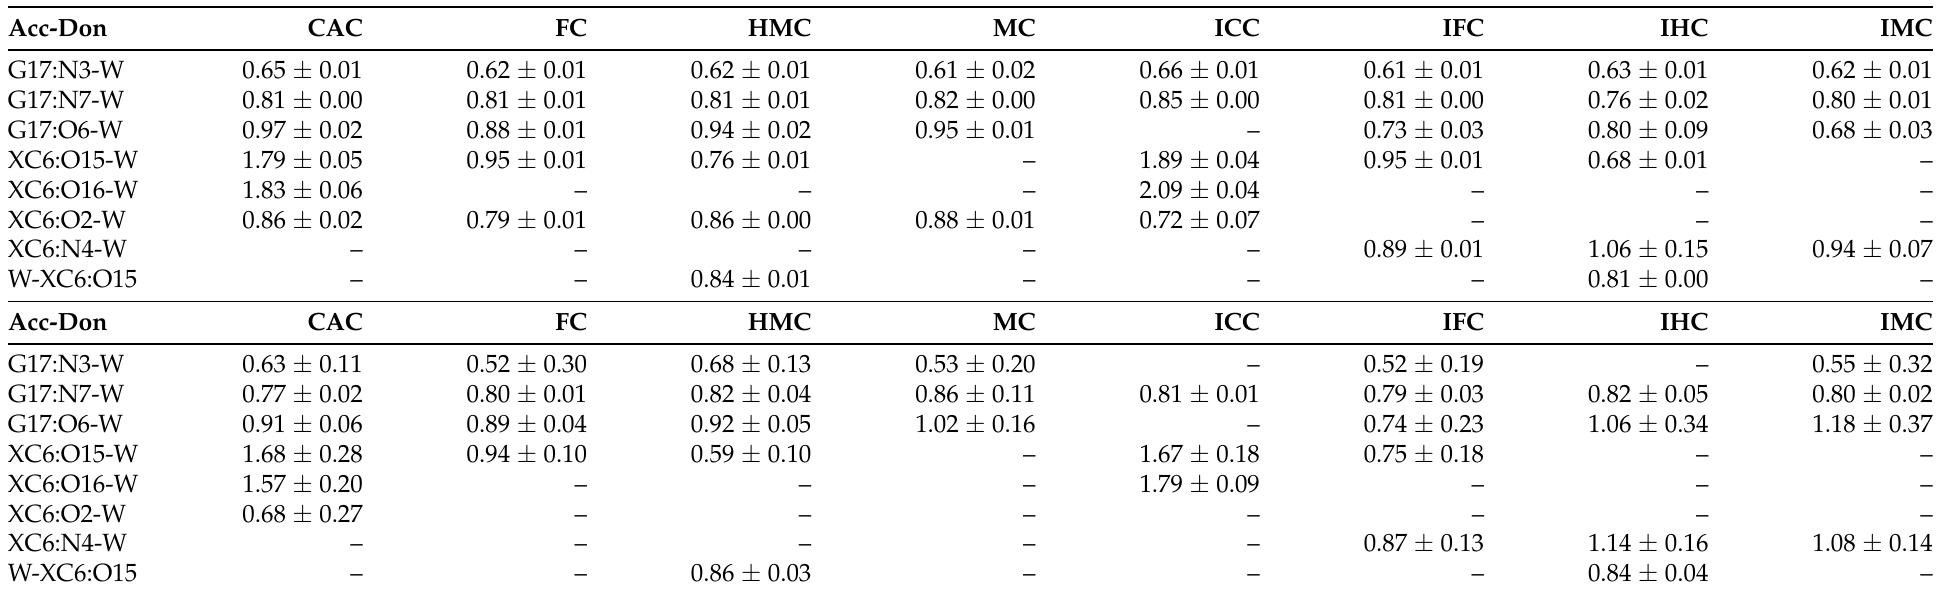
Table 3. Hydrogen bonds of the bases in the G:XC pair with water top: in free DNA and bottom: in DNA complexed to TDG. For atom labels see Figure 2. Note that probabilities larger than one correspond to more than one hydrogen bond formed